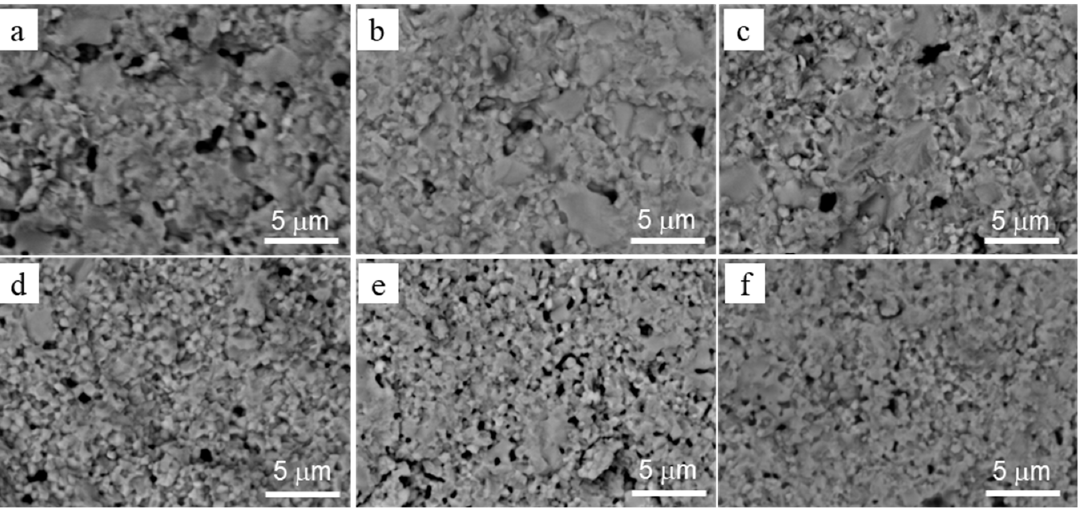
Figure 9. SEM-BSE images of the fracture surfaces for the studied materials containing ( a ) 3%, ( b ) 4%,